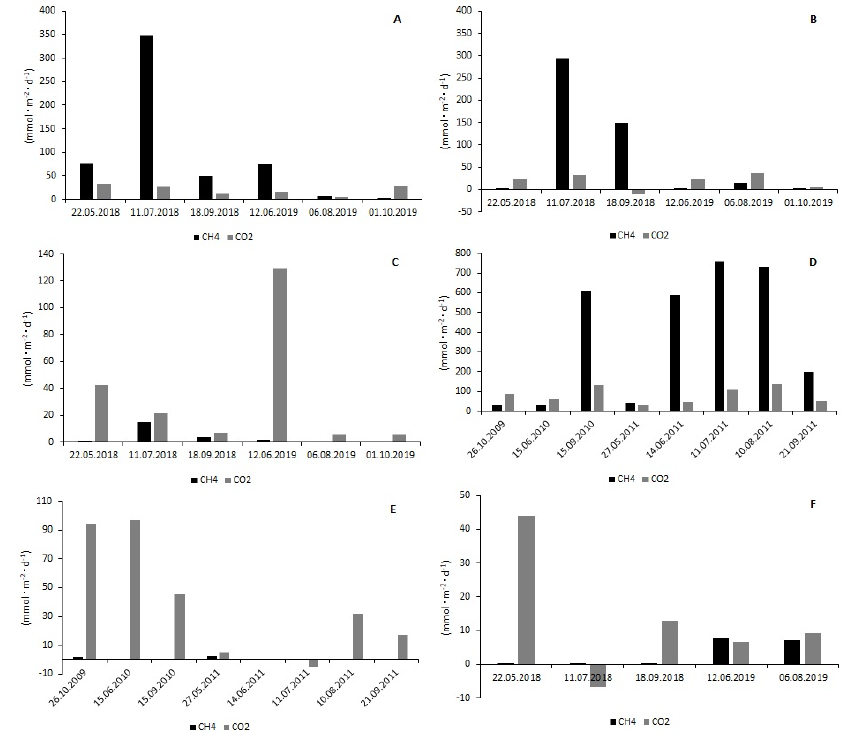
Figure 4. Time series of CH 4 and CO 2 fluxes at the water–air interface in Maziarnia Reservoir (panel A—station M1, panel B—M2, panel C—M3, panel D—M4, panel E—M5 and panel F—M6).